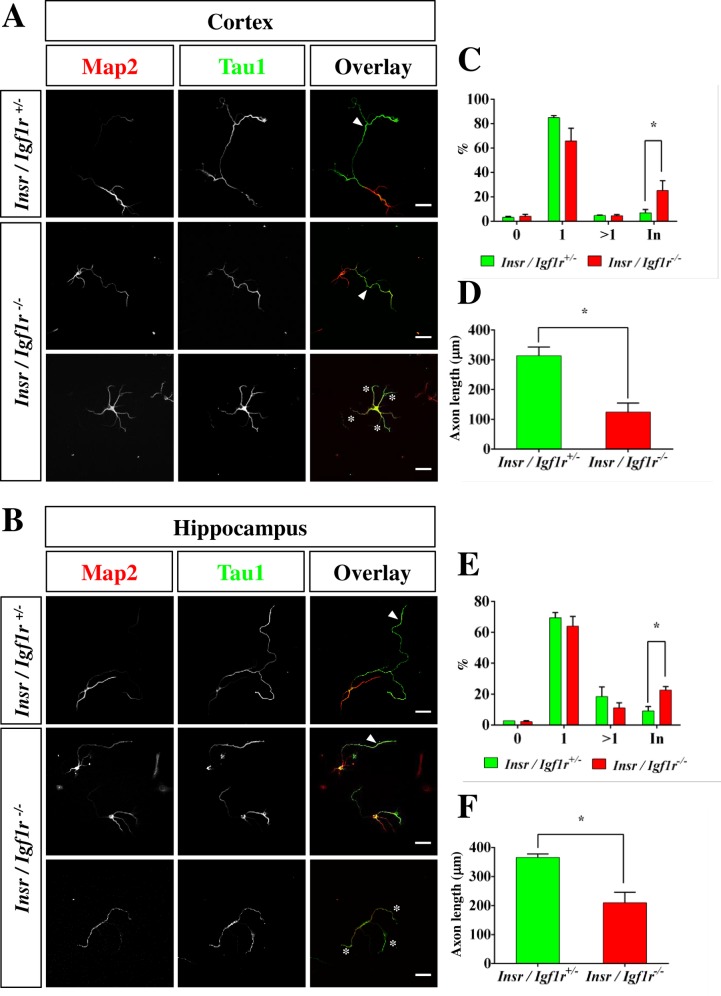
The loss of Igf1R and InsR impairs axon extension by cultured cortical and hippocampal neurons.(A, B) Neurons from the cortex (A) or hippocampus (B) of heterozygous (Ifg1r/Insr+/-) and homozygous (Igf1r/Insr-/-) E17 knockout embryos were analyzed at 3 days in culture (d.i.v.) by staining with an anti-Map2 (red) and the Tau-1 (blue) antibody. The scale bar is 20 μm. The majority of Igf1r/Insr-/- neurons extend a single axon (arrowhead, upper panels) but some Igf1r/Insr-/- neurons extend neurites that are positive for both of Map2 and Tau-1 (asterisks, lower panels). (C, E) The percentage (%) of unpolarized neurons without an axon (0), polarized neurons with a single axon (1), neurons with multiple axons (>1) and with multiple indeterminate neurites positive for both of Map2 and Tau-1 (In) from the cortex (C) and hippocampus (E) is shown (3 experiments, n>100 neurons, means ± s.e.m.; *, p<0.05 compared to heterozygous mice; two-way ANOVA). (D, F) The length of cortical (D) and hippocampal axons (F) from homozygous and heterozygous knockout embryos is shown (3 experiments, n>50 neurons, means ± s.e.m.; *, p<0.05 compared to heterozygous mice; Student’s t-test).